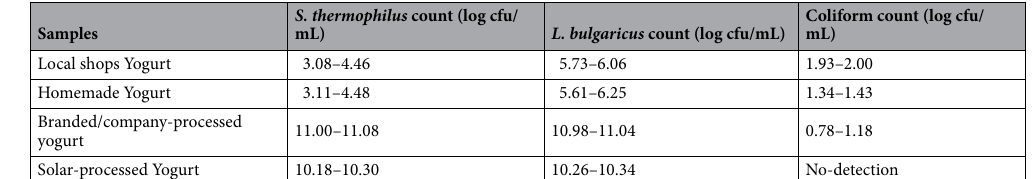
Table 4. Microbiological analysis of the yogurt samples collected from the local market of Faisalabad- Pakistan.